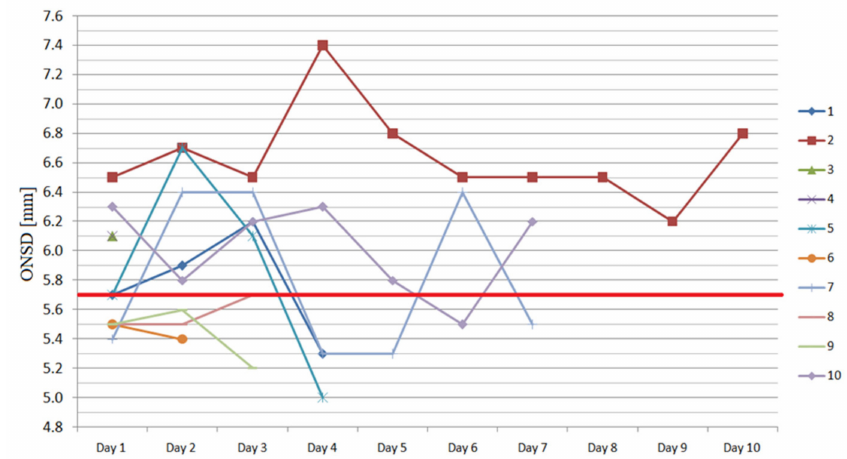
Figure 2. The consecutive measurements of the left eyeball ONSD during the study period (red transverse line shows the cut-o ff